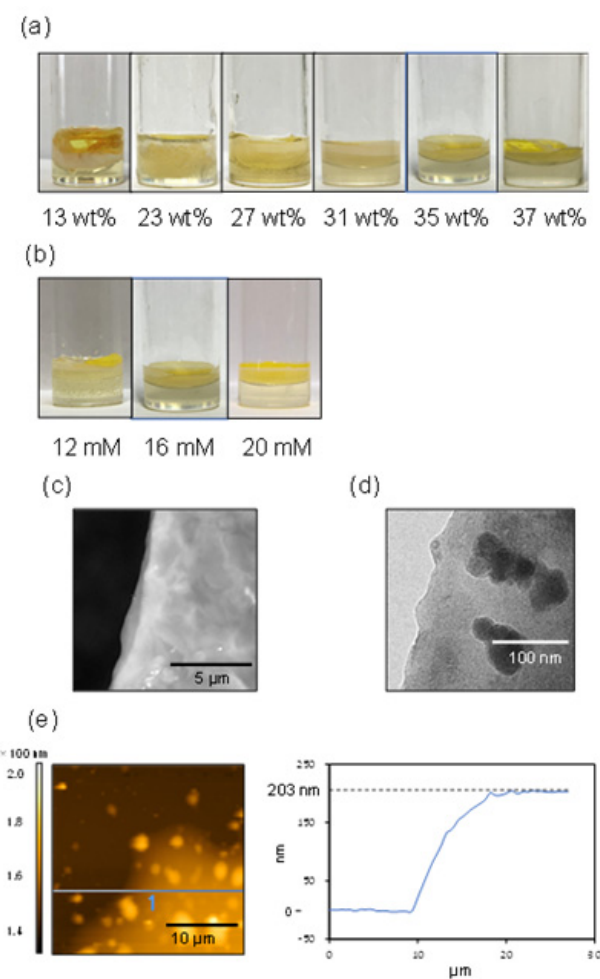
Figure 4. Photographs of ( a ) bottom-up synthesis of nanosheets by the addition of Au III aqueous solutions (16 mM) to NMP solutions of HPMC—34 (13—37 wt%) and ( b ) bottom-up synthesis of nanosheets by the addition of Au III aqueous solutions (12—20 mM) to NMP solutions of